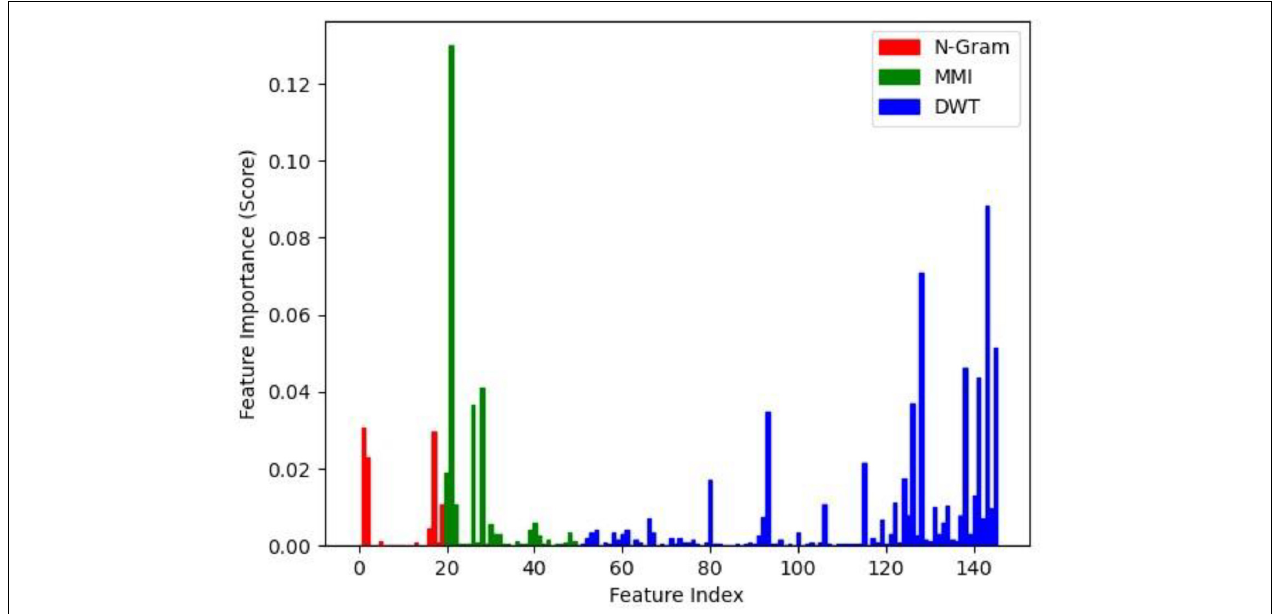
FIGURE 3 | The importance score of each